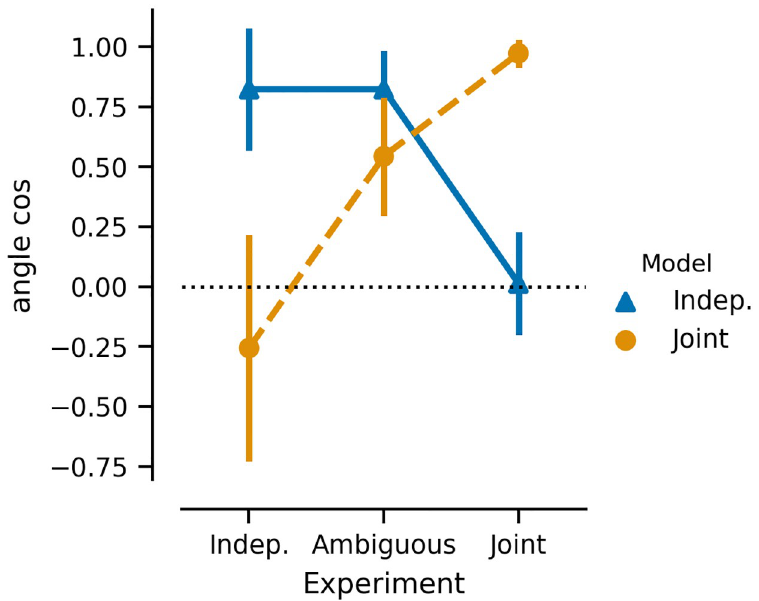
Fig 10. Comparison of human behavior to model to model predictions. Angle cosign between the vector of a priori model contrasts and human subject regression coefficients is shown for independent clustering (blue) and joint clustering (orange) across experiments 1 (joint structure), 2 (independent structure), and 3 (ambiguous structure) ordered by degree of joint structure in the tasks. Positive values (max = 1) reflect similarity between model prediction and human